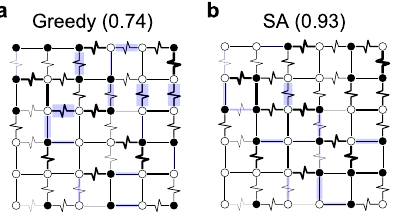
Fig. 1 | Case study comparison. We applied four algorithms: ( a ) Greedy, ( b ) Simulated annealing (SA), ( c ) Parallel tempering (PT), and ( d ) DIRAC (more pre- cisely, DIRAC m ) to compute the ground state of a randomly generated 6×6 Edwards-Anderson (EA) spin glass instance with fi xed boundary conditions and couplings J ij sampled from the Gaussian distribution N ð 0,1 Þ . The ferromagnetic bonds ( J ij >0) are shown with straight lines, while the anti-ferromagnetic bonds ( J ij <0) are shown with zigzag lines. The width of the lines are proportional to ∣ J ij ∣ . Nodes are fi lled/hollow if the spin values σ i =+1/ − 1, respectively. If the energy of a